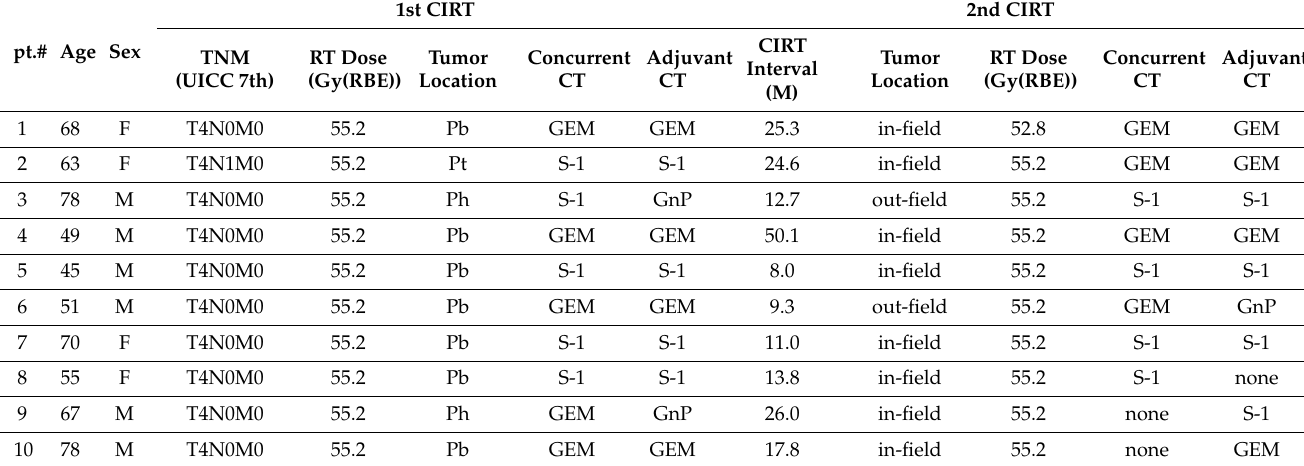
Table 1. Patients and CIRT